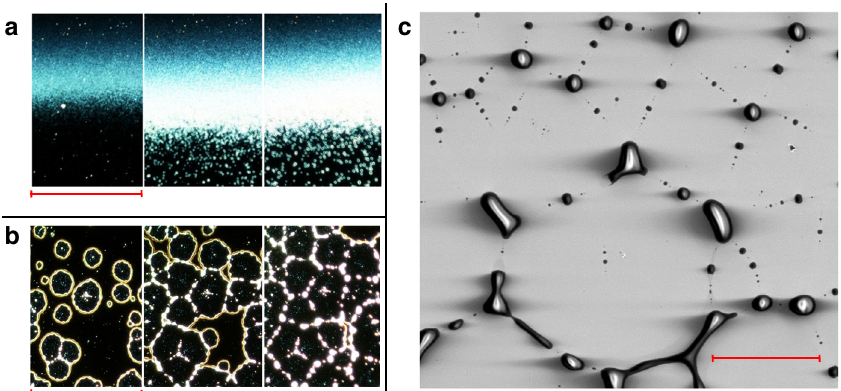
Fig. 1 Development of a [B 12 Cl 12 ] 2 − -based layer under ambient conditions. Left: Dark fi eld optical images showing the development of a the border (left to right 2, 30, 60 min, scale bar = 435 µ m) and b the middle of the spot (left to right 1, 8, 15 h, scale bar = 140 µ m) generated by mass-selected deposition of [B 12 Cl 12 ] 2- onto FSAM over time during exposure to ambient conditions. Dewetting is observed throughout the layer. c Scanning electron microscopy (SEM) image showing the formation of droplets at the end of the dewetting process (scale bar = 100